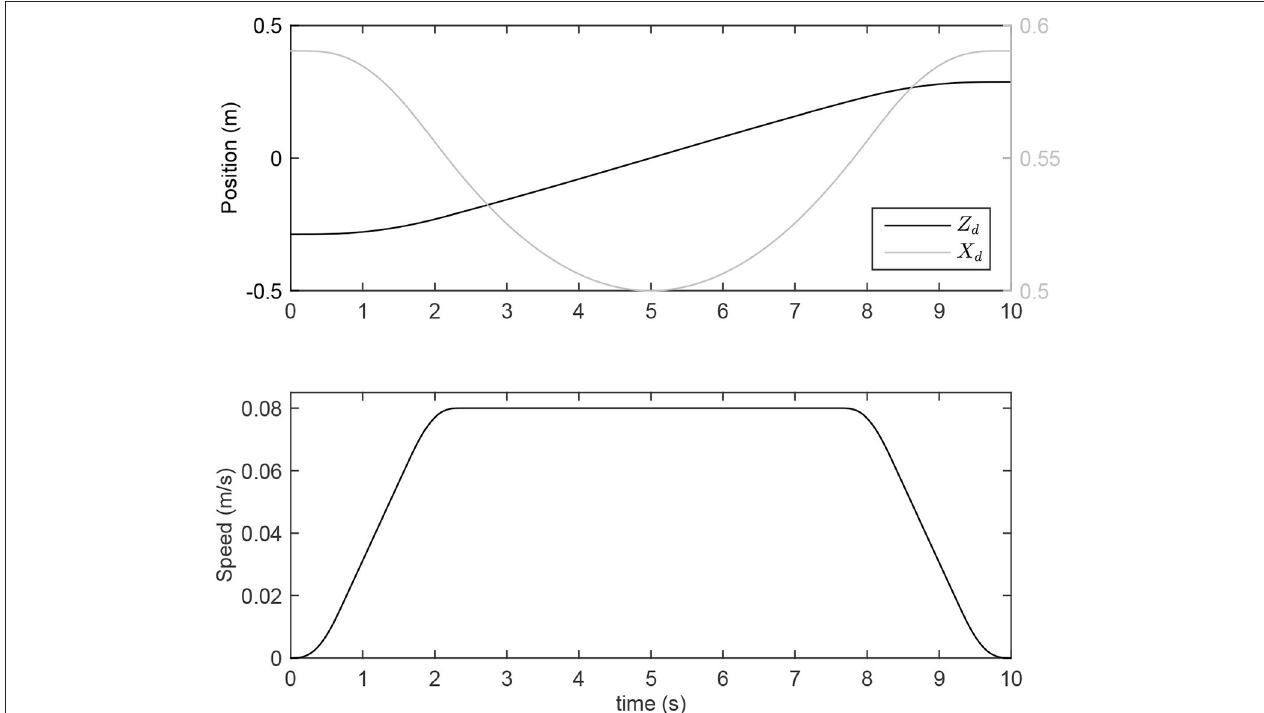
FIGURE 3 | Desired position and speed for point-to-point reaching